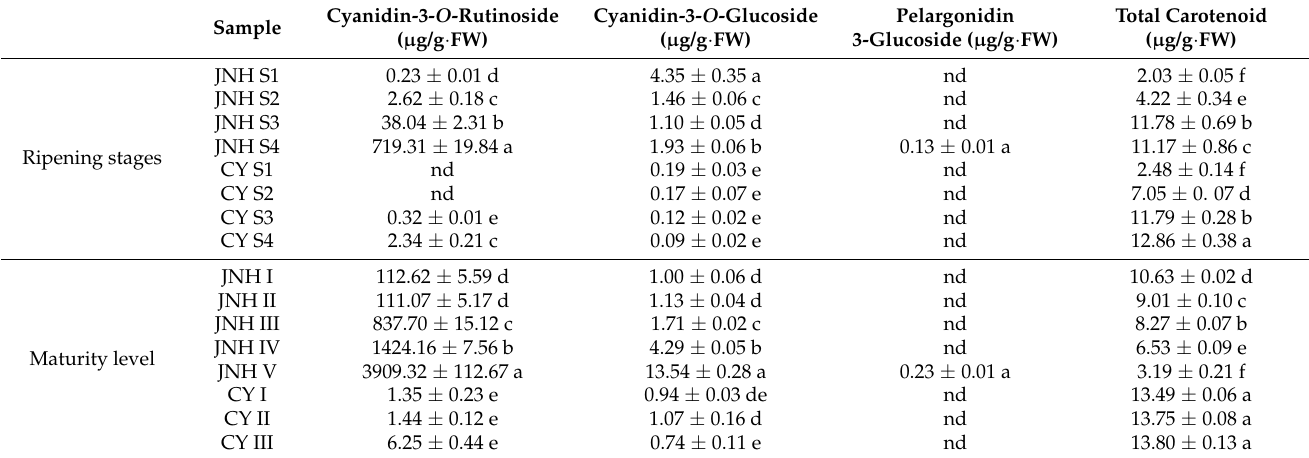
Table 3. Anthocyanin and carotenoid content in the fruits of cultivars in different developmental stages.